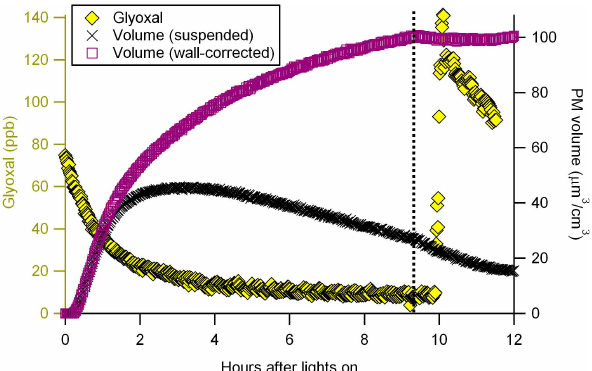
Fig. 6. The time traces of glyoxal and particle volume concentration (suspended and wall-loss corrected) (Run 1501A). The dashed line indicates the time blacklights were turned off. Addition of glyoxal ( ∼ 100ppb) at 10h into SOA seed system did not form significant